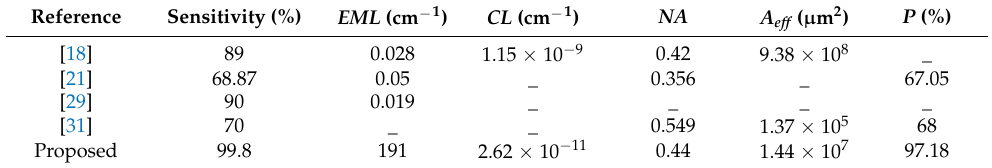
Table 1. Comparison between the parameters of the sensor in the proposed MSF with reported re- sults.